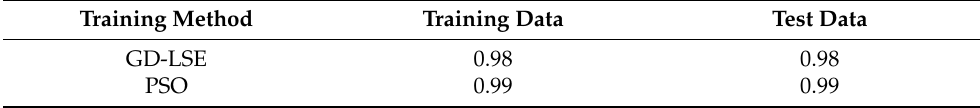
Table 5. Summary of R coefficients obtained for the evaporator outlet temperature